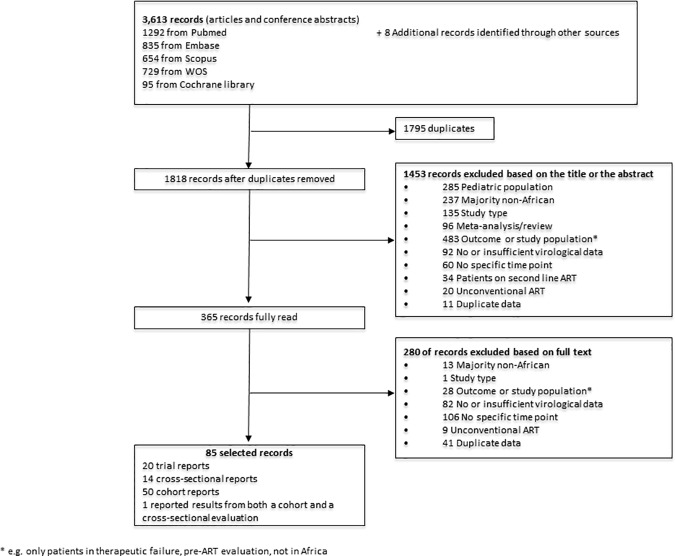
Flow chart of study selection.